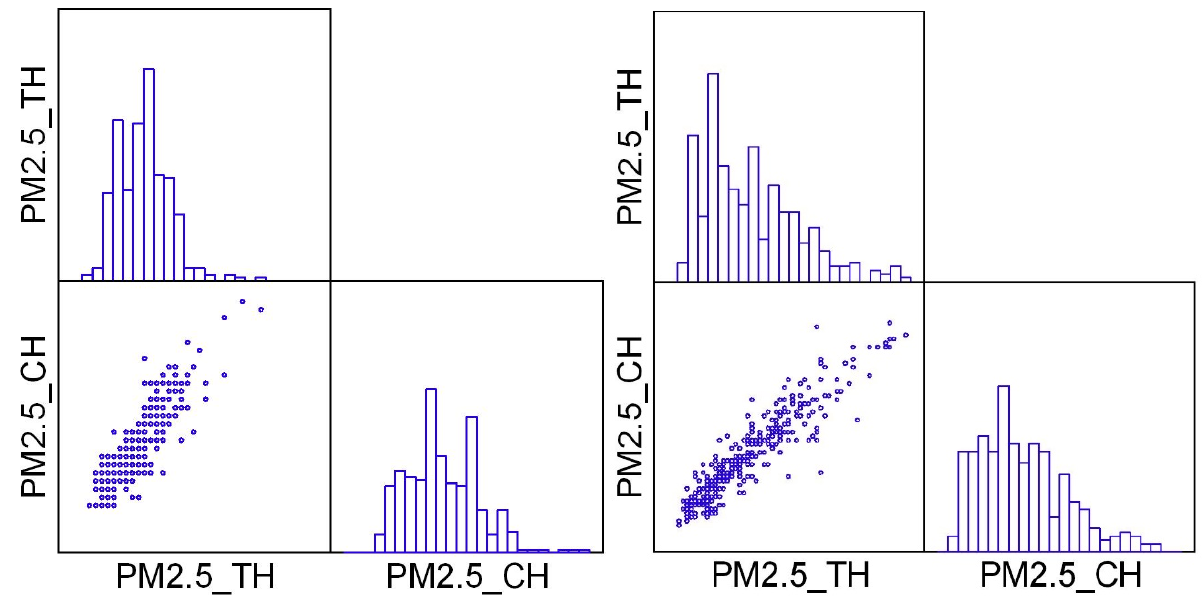
Figure 9. Scatterplot of PM2.5 measured in the urban background stations TH and CH, summer ( left ) and winter ( right ) semester.